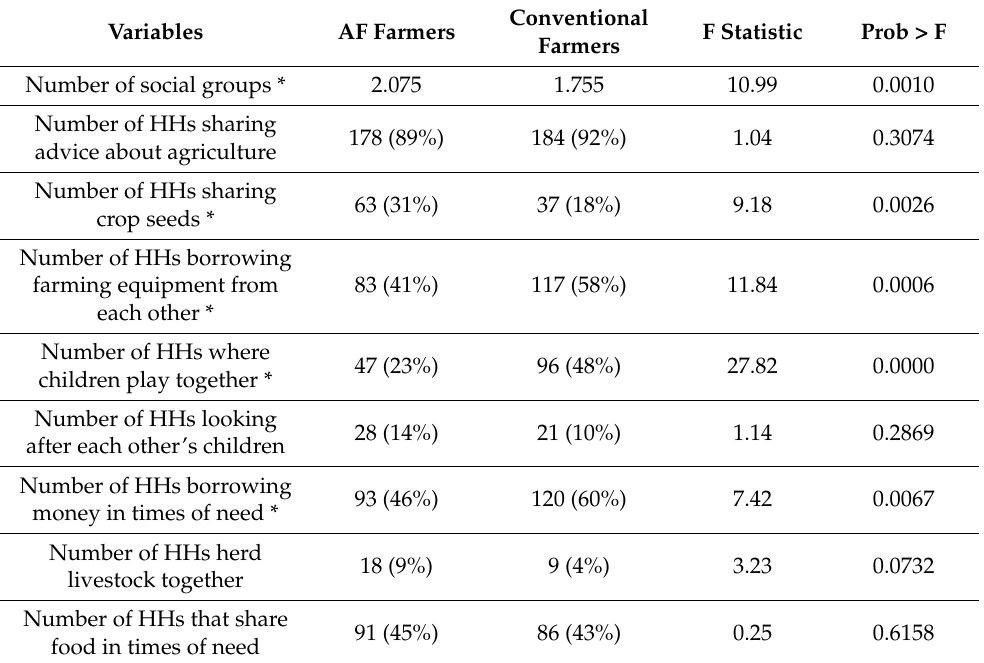
Table 5. Comparative analysis of the social capital of AF and CF